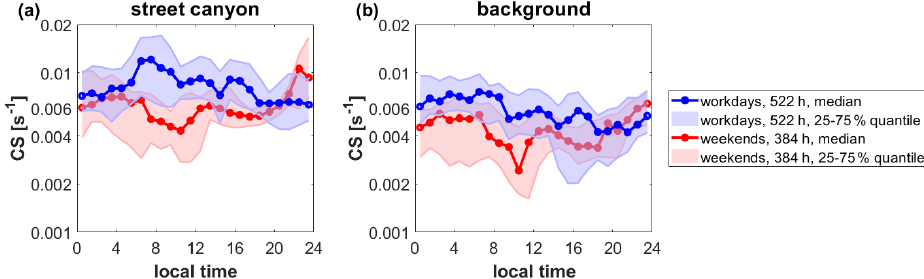
Figure 5. The diurnal variation of CS during weekends (red) and workdays (blue) (a) at the street canyon and (b) at the background station. The median diurnal variation is shown as a solid line with markers; the 25th and 75th percentiles are presented as a shaded area.